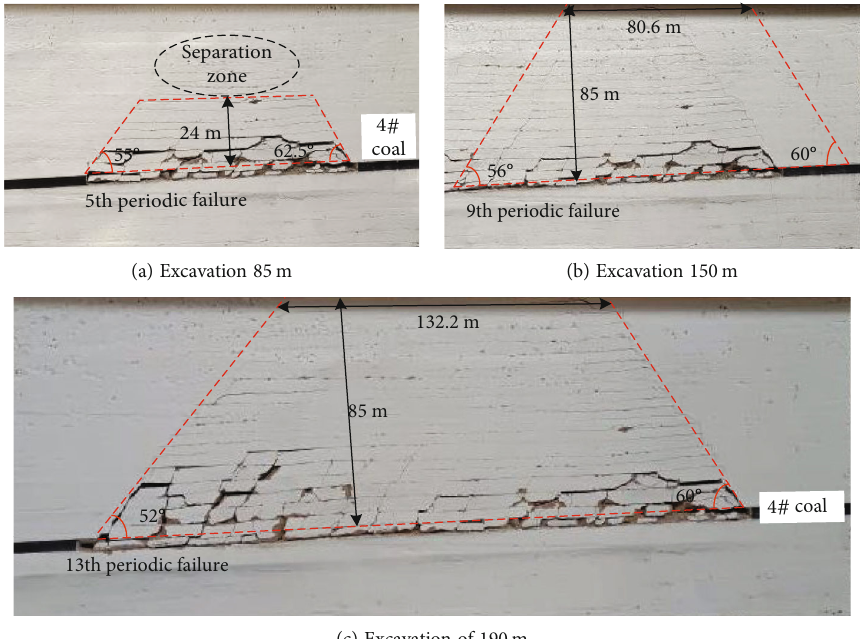
Figure 3: Periodic weighting of coal seam.